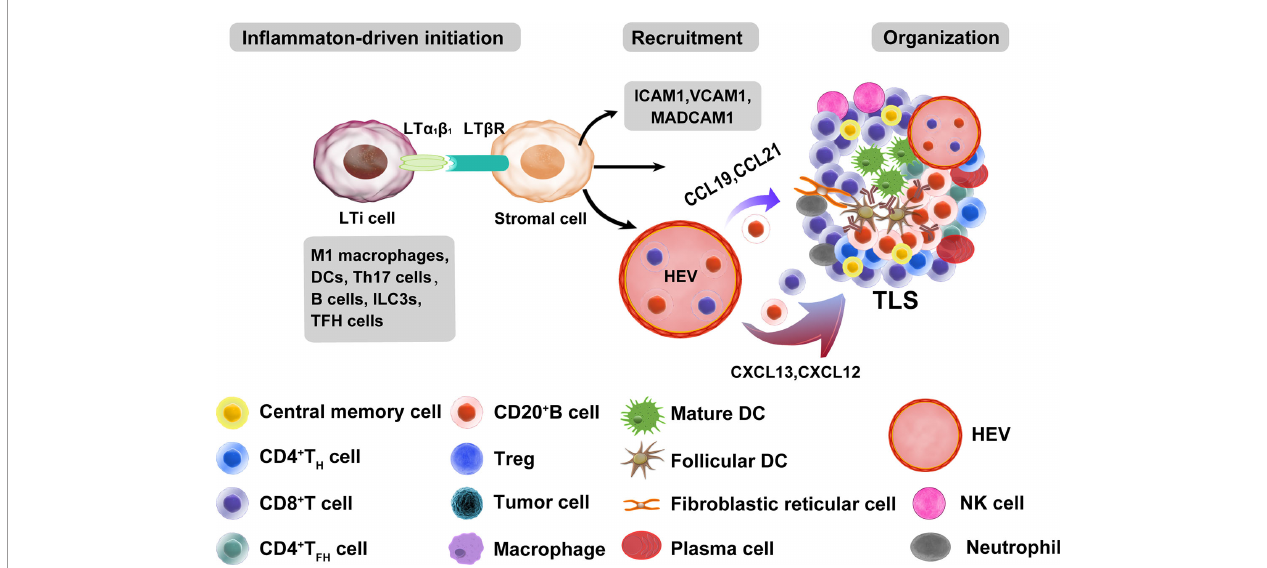
FIGURE 1 | Main molecular and cellular mechanisms of TLS formation in tumors. The development of TLSs is similar to that of SLOs. A chronic in fl ammatory state is suf fi cient to induce TLS formation in the absence of lymphoid tissue inducer (LTi) cells. Many immune cells can be used as LTi cells, such as B cells, DCs, M1 macrophages, Th17 cells, ILC3s, and TFH cells. Immune and stromal cell cross-talk mediates TLS formation mainly through the binding of lymphotoxin (LT) ab and LT b R, which can further release many chemokines (CXCL13, CXCL12, CCL21, and CCL19) and adhesion molecules (VCAM1, ICAM1, and MADCAM1). These chemokines recruit lymphocytes from HEVs and form T and B cell zones. ILC3s, group 3 innate lymphoid cells; VCAM1, vascular cell adhesion molecule 1; ICAM1, intercellular adhesion molecule 1; MADCAM1, mucosal addressable cell adhesion molecule